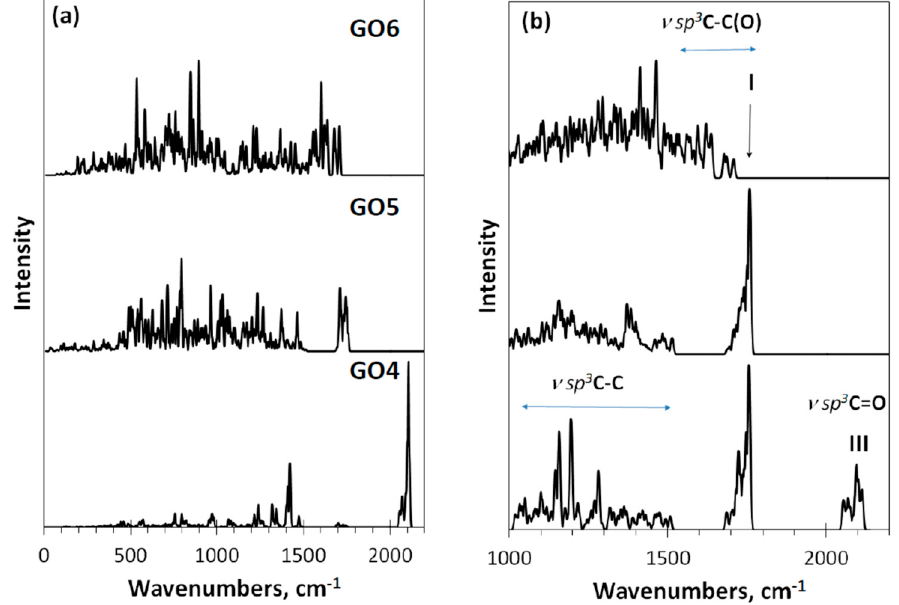
Figure 6. Virtual one-phonon IR absorption ( a ) and Raman scattering ( b ) spectra of digital twins GO4, GO5, and GO6. RHF AM1 calculations.